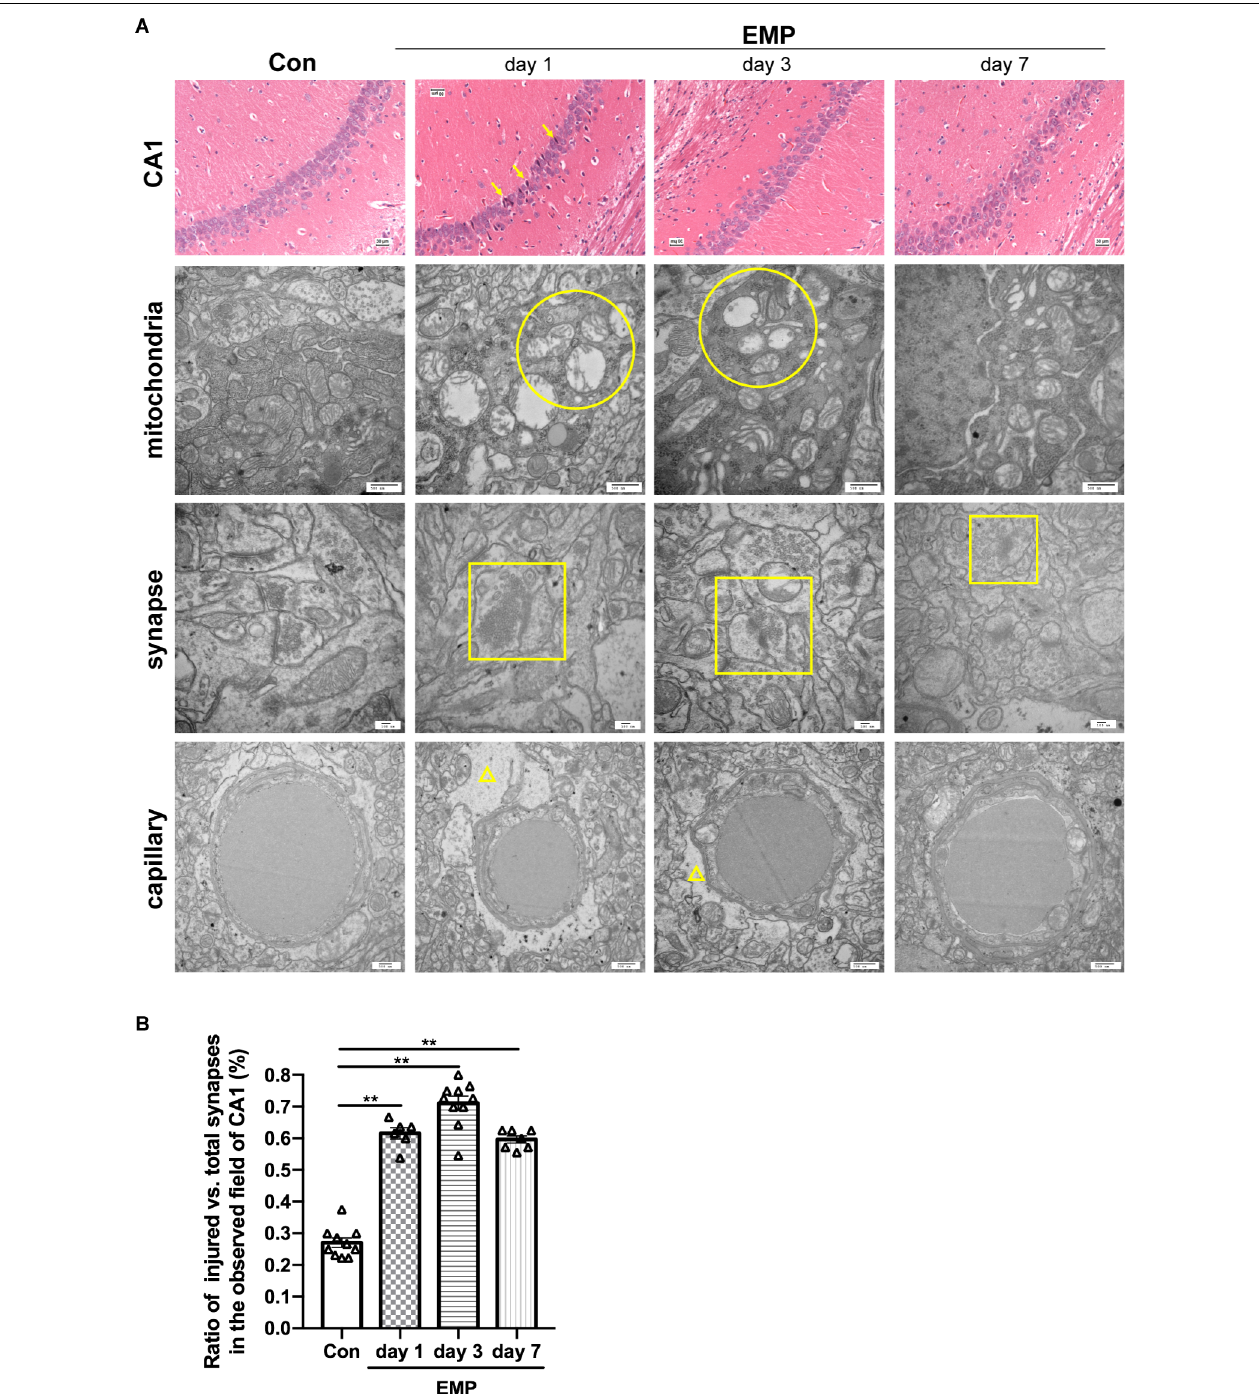
FIGURE 8 | EMP exposure damages the structures of hippocampal CA1 neurons in mice ( n = 3 mice per group). (A) On day 1, day 3, and day 7, mice were anesthetized with pentobarbital sodium and then decapitated. The brain was isolated and stained with H&E. The structures of the hippocampi were observed under an optical microscope, and representative images of the CA1 area were presented. The ultrastructure of CA1 neurons was observed by transmission electron microscope, and representative images of the mitochondria, synapses, and capillary were shown. Scale bar = 30 µ m for H&E, 500 nm for transmission electron microscopy. Arrows, the damaged neurons in CA1; circular, the mitochondria with swelling, crista breakage, and fragmentation; square, the injured synapses; triangle, the widened perivascular space. (B) Statistical analysis of the ratio of injured vs. total synapses in hippocampus of different groups. Two to four fields of hippocampal CA1 per mice from three biological replicates was used for quantitative analysis. The data are presented as mean ± SEM. Student’s t -test was performed to evaluate the differences between the EMP-exposed groups at different time points with the Con. ** p < 0.01.